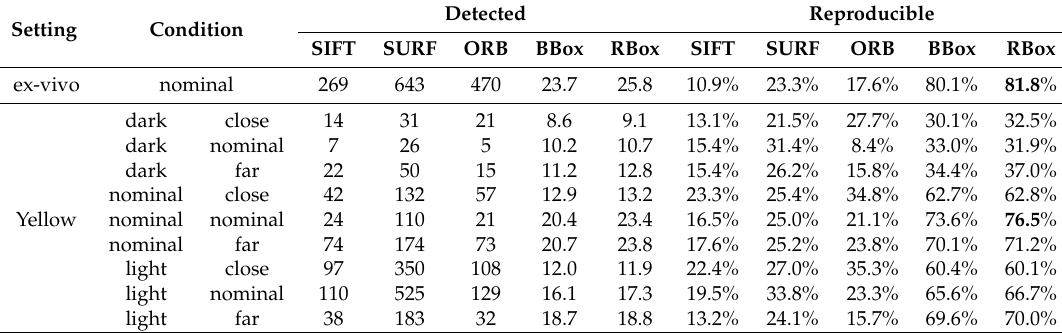
Table A1. Experiment 1: Key-points/regions